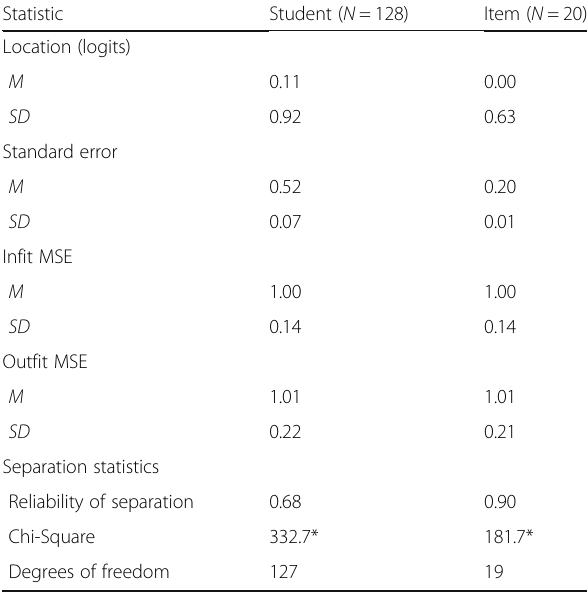
Table 1 Summary statistics from the dichotomous Rasch